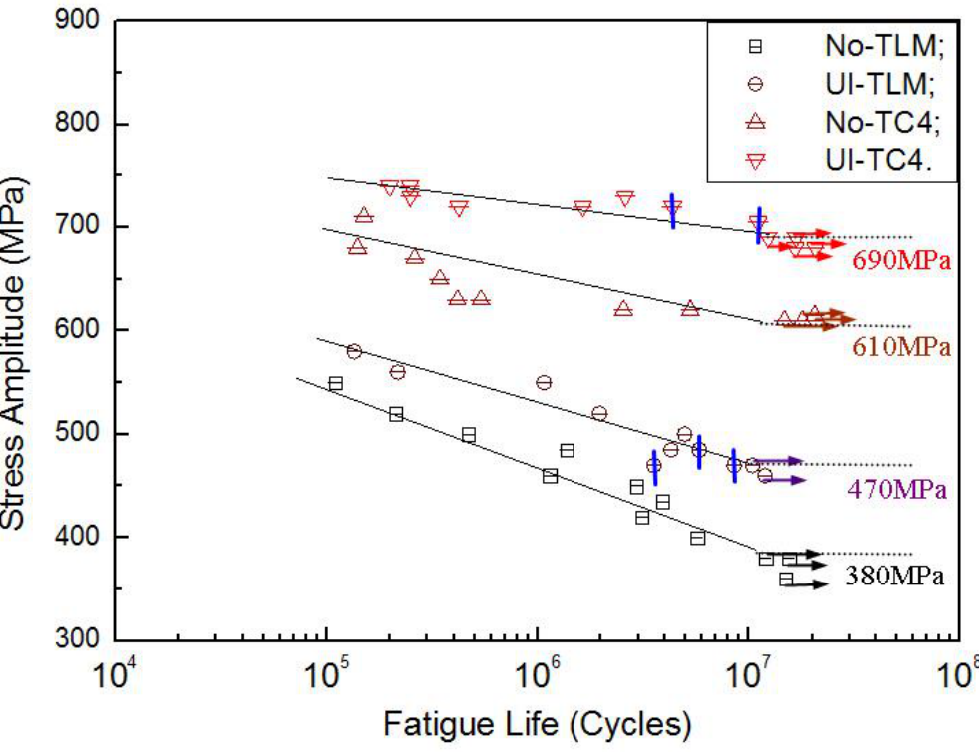
Figure 6. Rotating–bending fatigue S–N curves of TC4 and TLM titanium alloys.